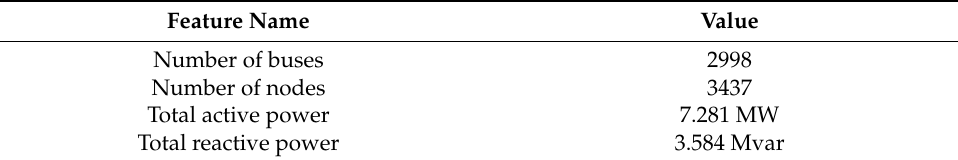
Figure 2. EPRI’s Circuit 5. Table 1. Circuit 5 technical features.